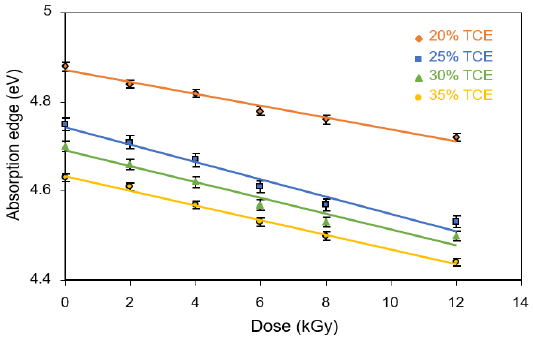
Figure 8. Absorption edge of PVA-TCE-CR polymer films as a function of dose for different TCE compositions.